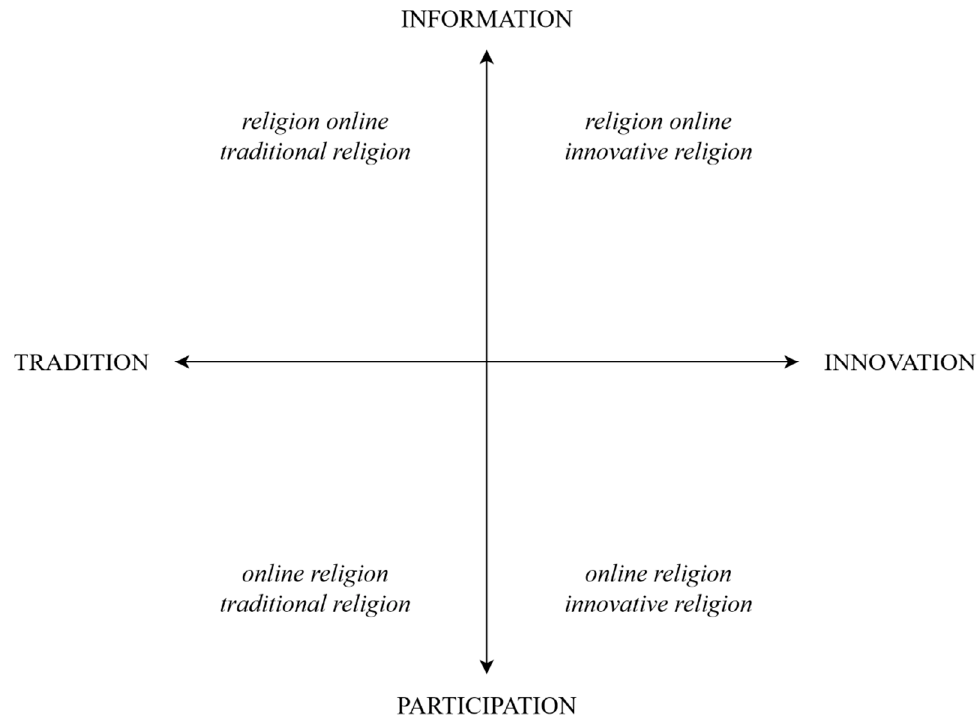
Figure 1. The visual frame for mapping online religious spaces.